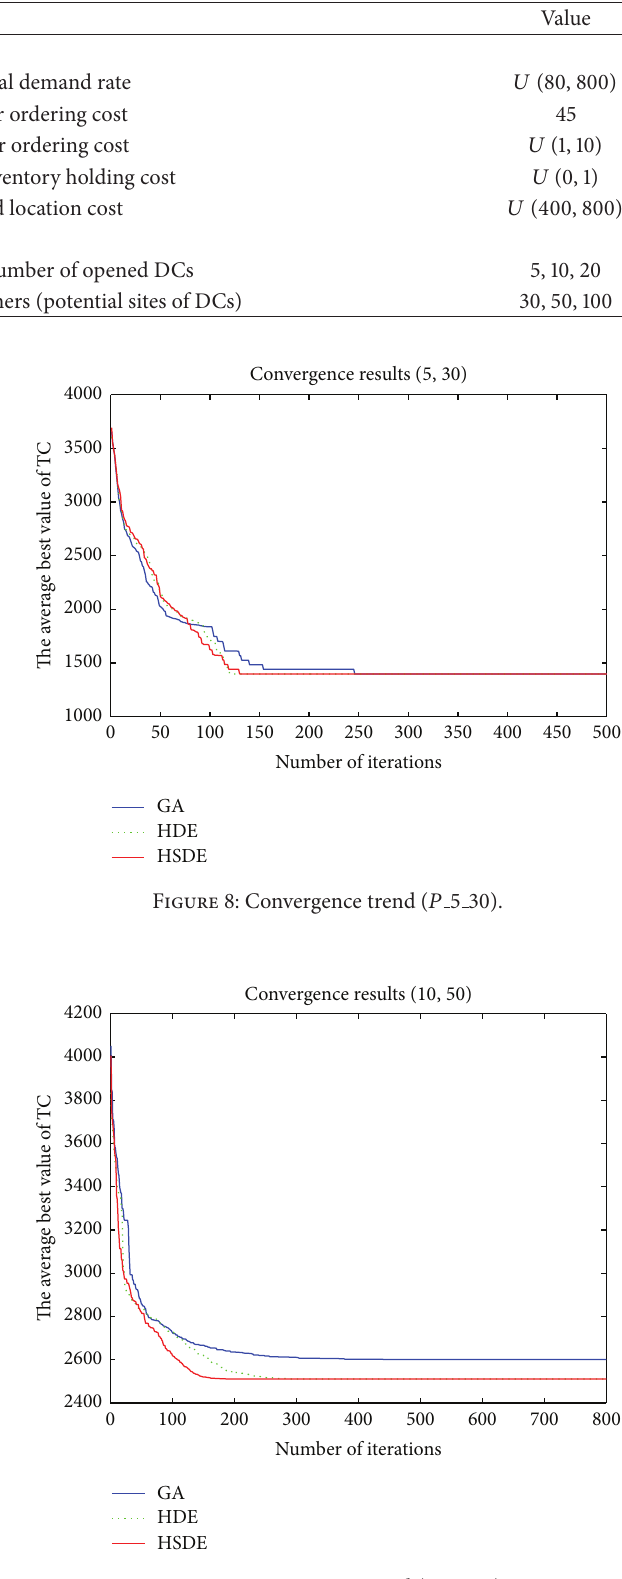
Figure 9: Convergence trend ( 𝑃 10